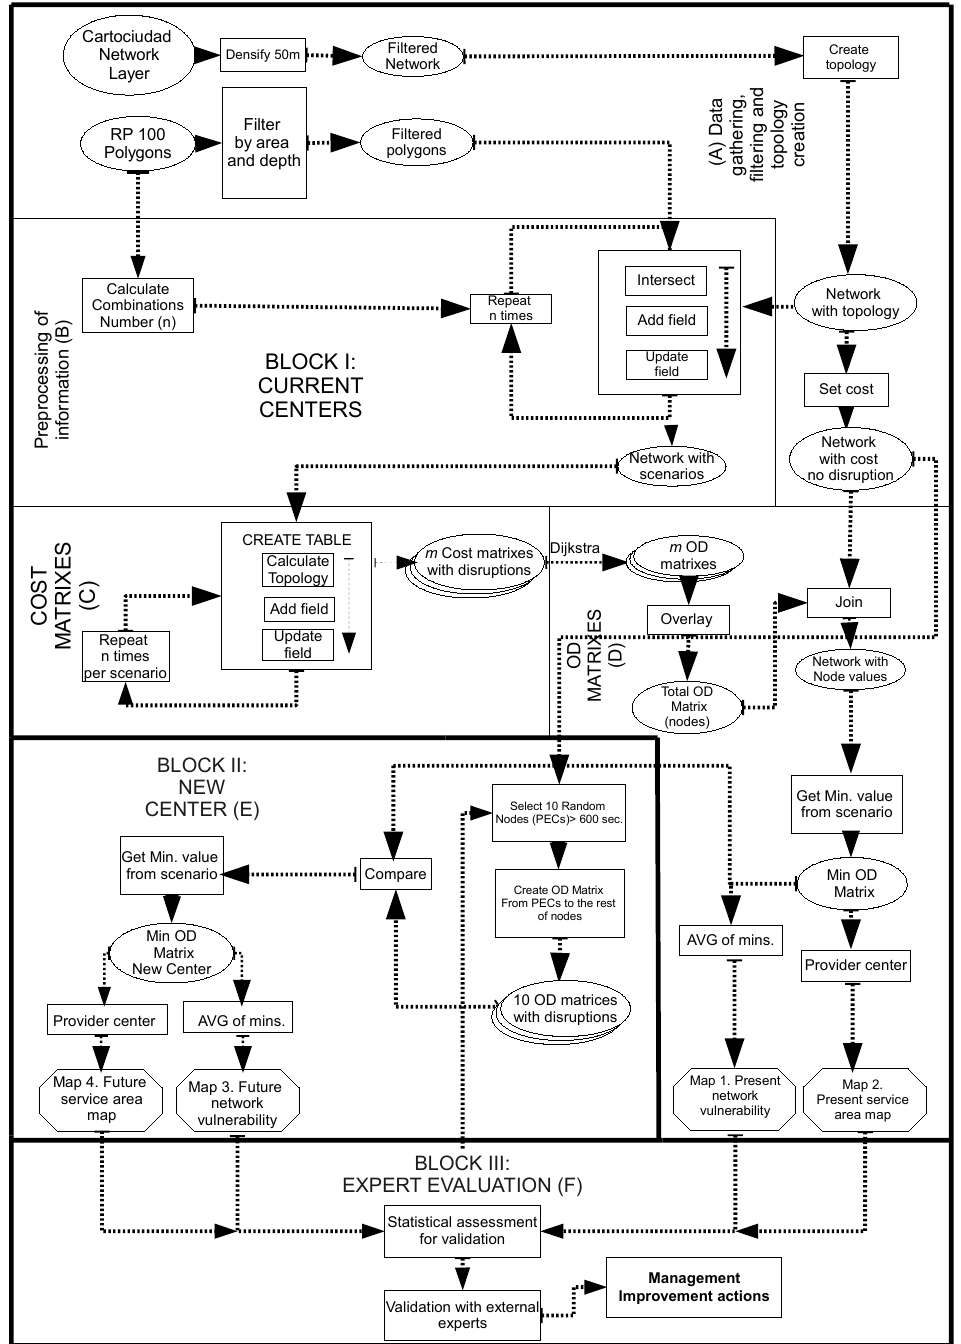
Figure 1. Conceptual scheme of the work carried out. Flow line connectors show the direction that the process flows; Rectangles show spatial instructions or actions; Ellipses show partial results, and are the input information of the next process; as a result, octagons show final